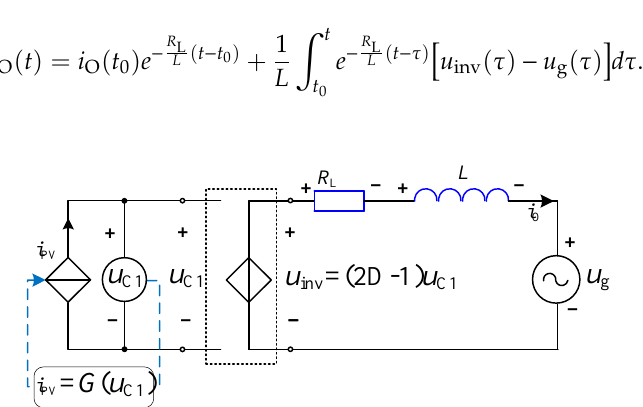
Figure 4. Simplified circuit of photovoltaic grid-connected inverter.